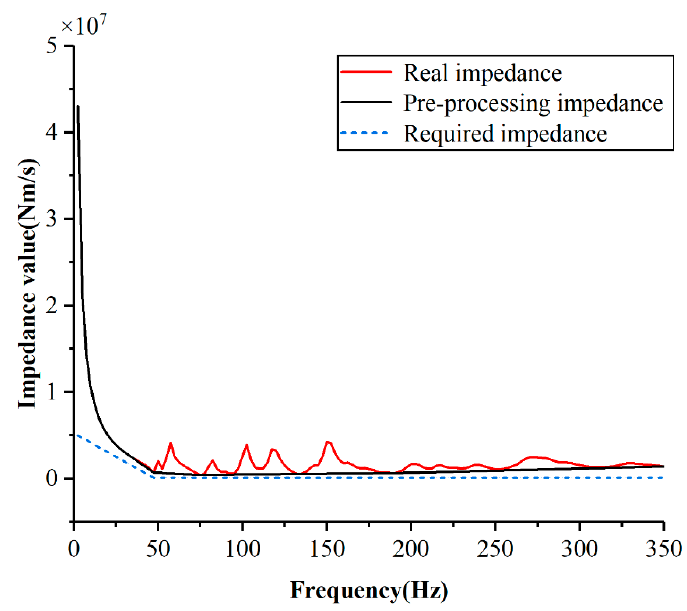
Figure 9. The impedance curves before and after pre-processing.